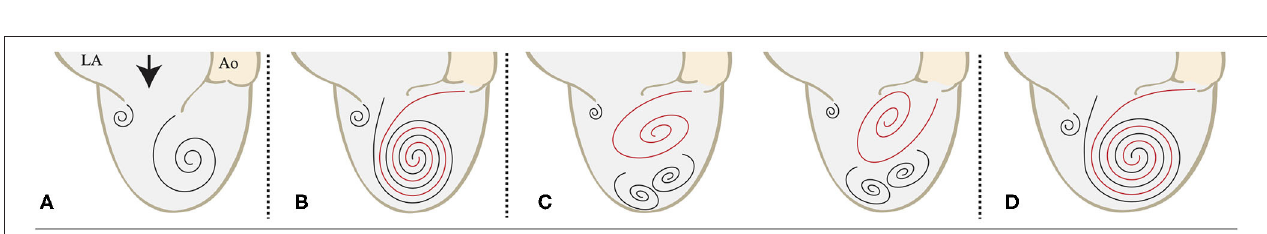
FIGURE 3 | Main findings of this study. Black dots represent symptomatic patients, whereas white dots represent asymptomatic patients. The mean energy loss of one cardiac cycle is higher in the symptomatic group than in the asymptomatic group ( p = 0.040) (A) . The diastolic diameter is higher in the asymptomatic group than in the symptomatic group ( p = 0.040) (B) . mEL, mean energy loss in one cardiac cycle. * p < 0.05.